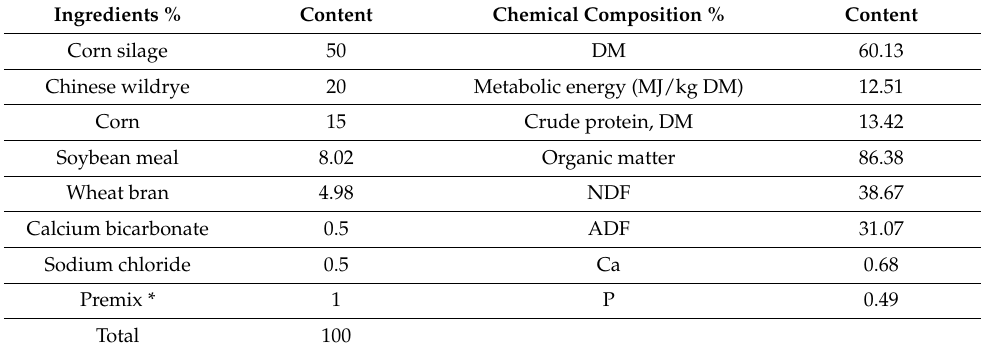
Table 1. Ingredients and nutrient composition of experimental diets (DM